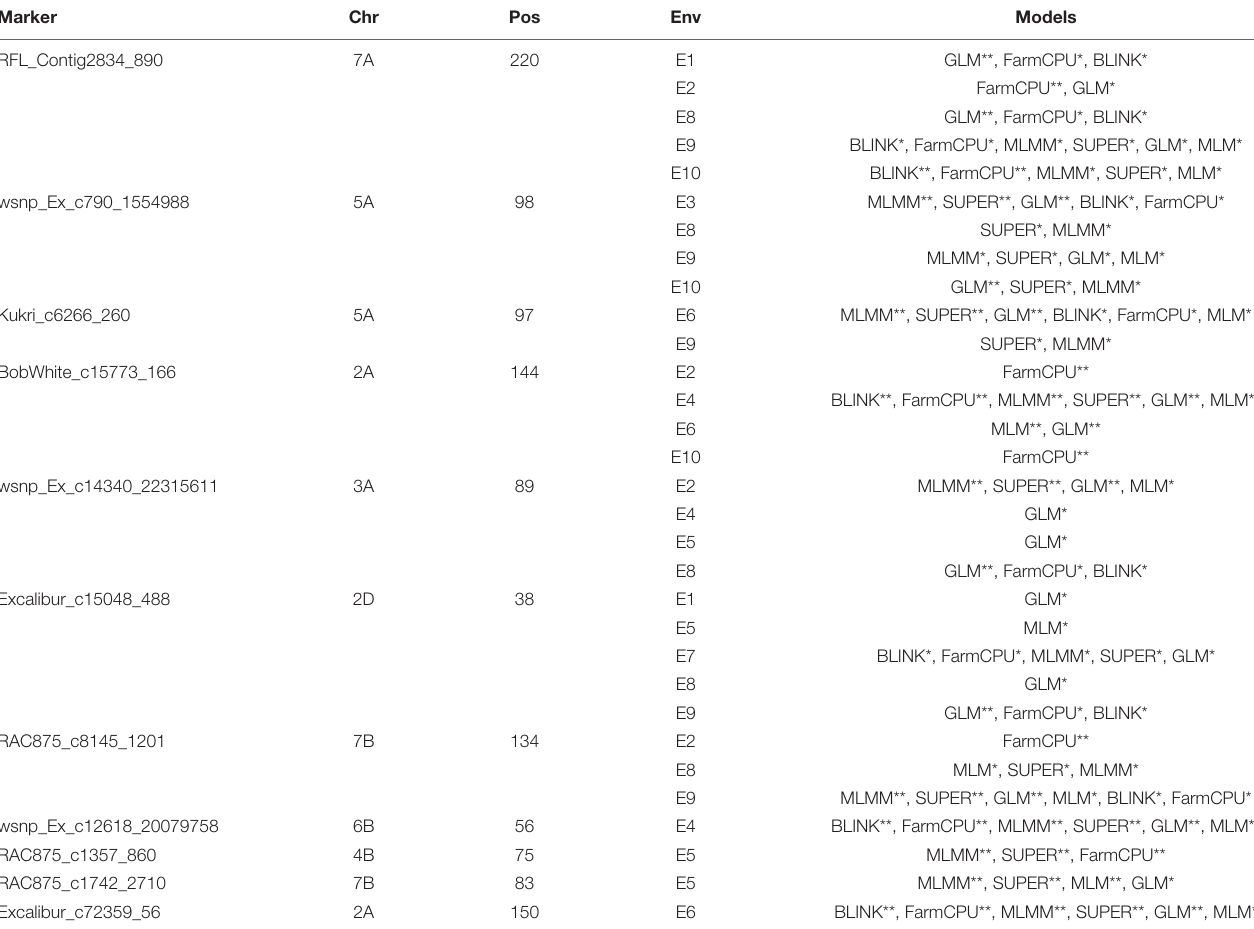
TABLE 3 | Summary of GWAS for SNP markers with significant and stable marker trait associations for powdery mildew. Marker Chr Pos Env Models